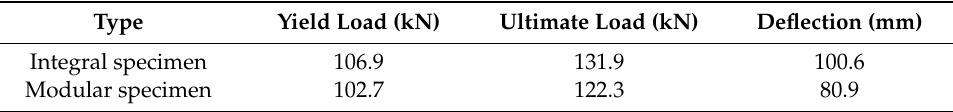
Figure 3. Load-deflection curve. Table 2. Results of the static loading test for the integral and modular specimens.